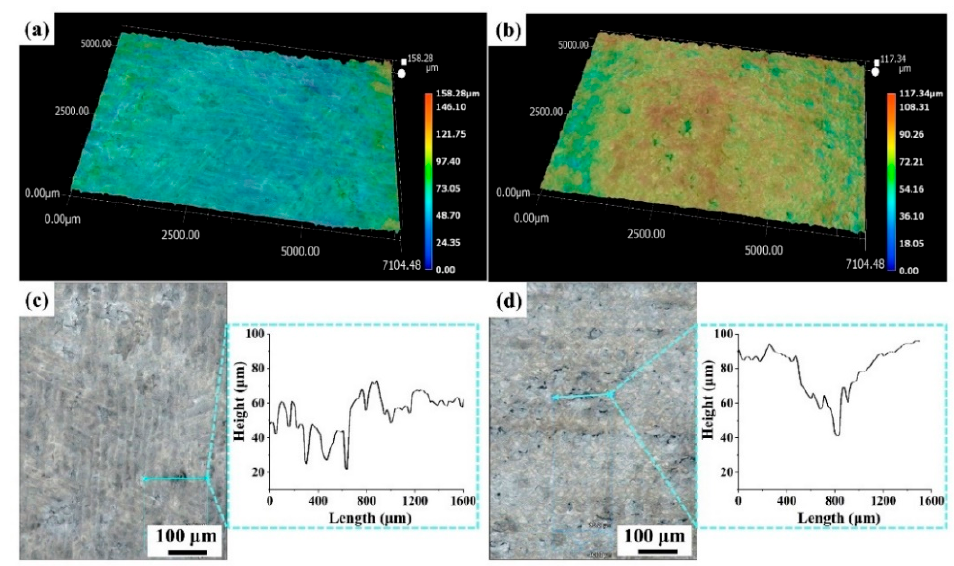
Figure 10. Three-dimensional surface morphologies of the as-built alloy after IGC tests: ( a ) surface roughness of XY plane; ( b ) surface roughness of XZ plane; ( c ) corrosion morphology and the depth of a corrosion pit for ( a ); ( d ) corrosion morphology and the depth of a corrosion pit for ( b ). The open circuit potential (OCP) evolution with time for the as-built samples tested in 3.5 wt.% NaCl solution (25 ◦ C) was monitored prior to performing other electrochemical tests, and the results are shown in Figure 11a. The OCP values of the XY and XZ planes are stabilized at − 901.54 mV (vs. SCE) and − 989.05 mV (vs. SCE), respectively, indicating that